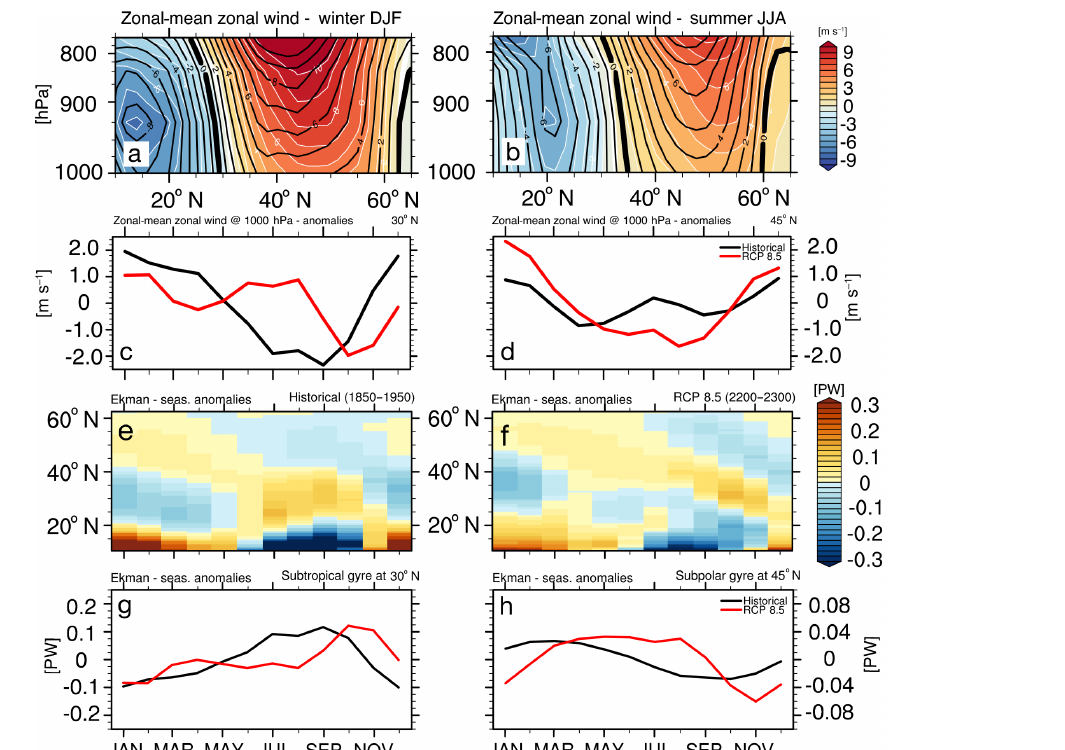
Figure 8. The zonal-mean zonal wind (ms − 1 ) over the North Atlantic averaged from 10 ◦ E to 90 ◦ W and the associated Ekman heat transport seasonal cycle (PW). (a–b) Vertical profile of the zonal wind for historical conditions (1850–1950, black contours) and RCP 8.5 (2200–2300). Contour interval in (a) and (b) is 1ms − 1 . (c–d) Seasonal cycle of the surface wind at 30 and 45 ◦ N for historical conditions (1850–1950, black) and RCP 8.5 (2200–2300, red). (e–f) Seasonal cycle of the Ekman heat transport (in PW) in the historical simulation (1850–1950, left panel) and RCP 8.5 (2200–2300, right panel). (g–h) Seasonal cycle of the Ekman heat transport at 30 and 45 ◦ N for historical conditions (1850–1950, black) and RCP 8.5 (2200–2300, red). Shown are anomalies relative to the annual mean at every latitude. Contour interval in (e) and (f) is 0.02PW. Please note the different vertical axes in (c) , (d) and (g) , (h)